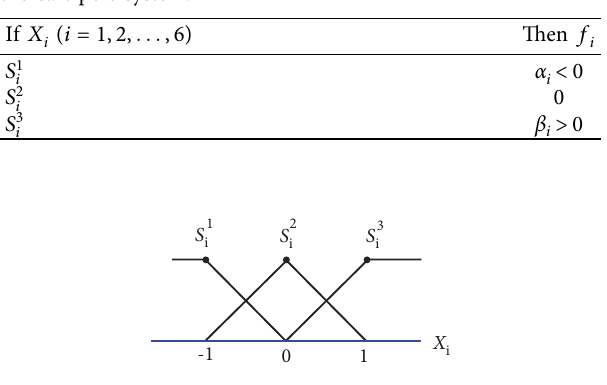
Table 3: Fuzzy rules of SFSs related to three dynamical variables of the pole.